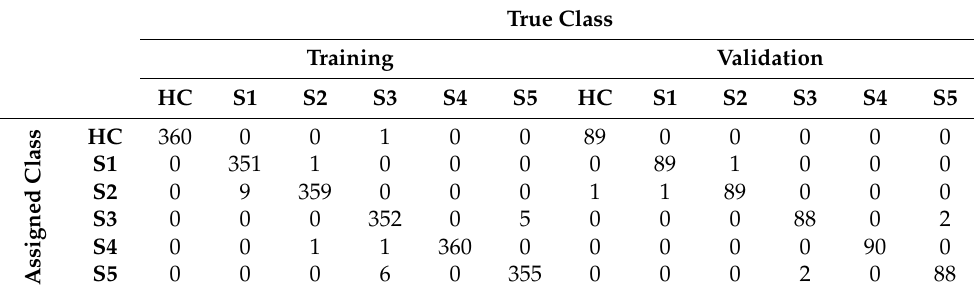
Table 4. The confusion matrix achieved during the training and validation of the proposed NN- based